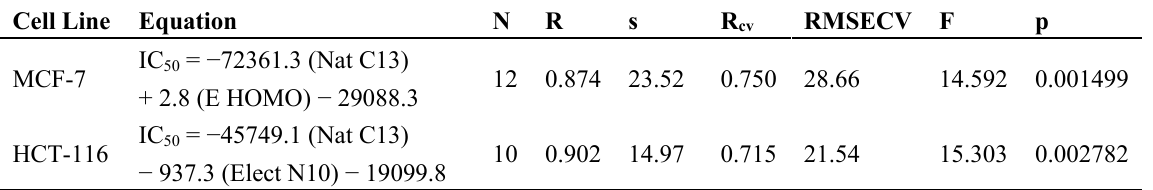
Table 4. The QSAR equations and their predictive performance in predicting cytotoxic activity of the 1,1-dioxo-1,4,2-benzodithiazine derivatives against MCF-7 and HCT-116 cell lines.